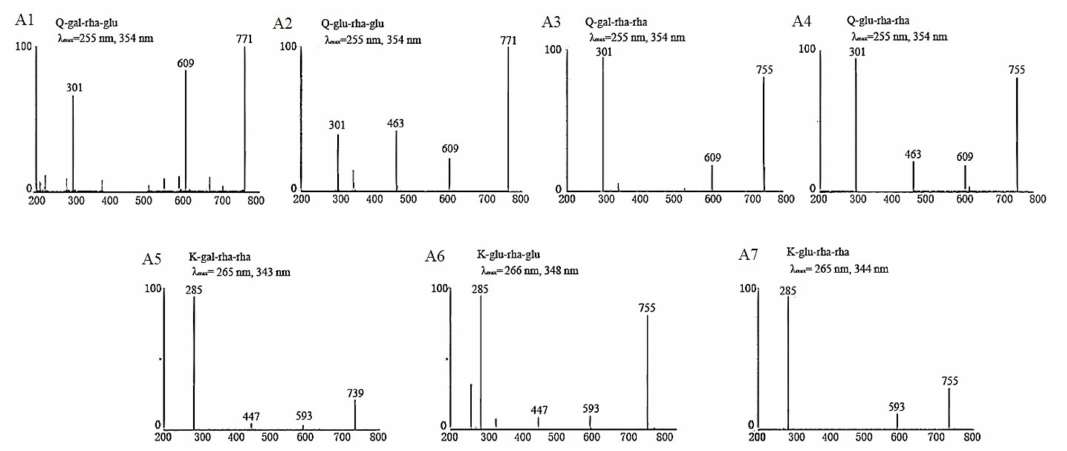
Figure 4. The basic characteristic information of isolated